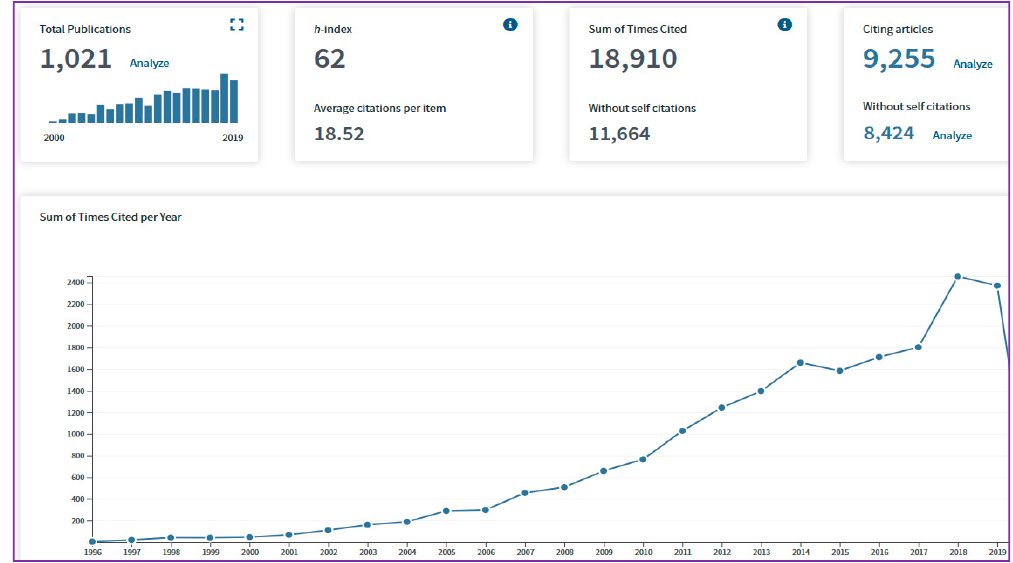
Figure 2. Numbers of publications on RJ that appear from international journals are increasing every year (data from the core collection of the Web of Science).